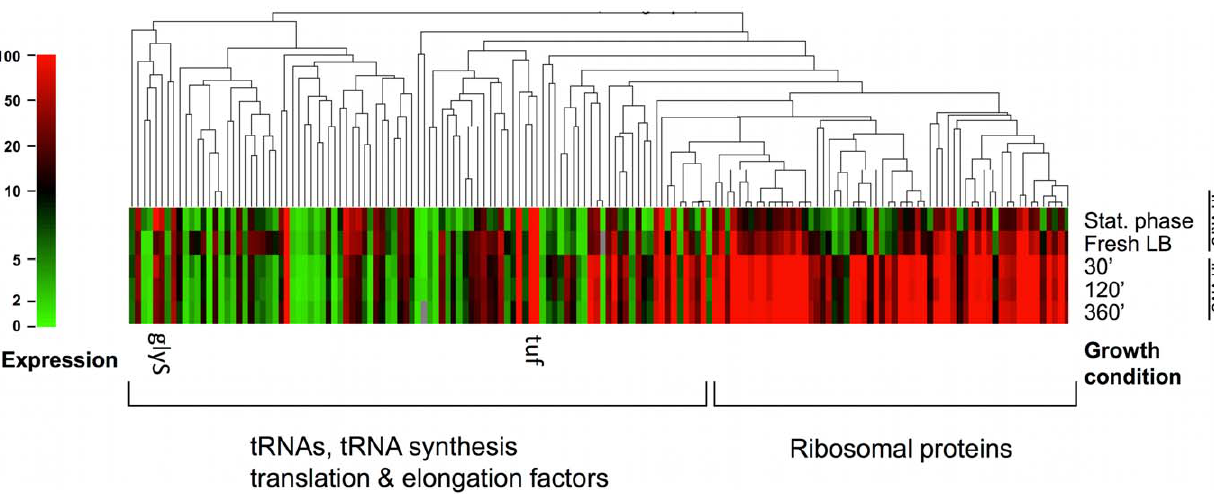
Figure 5. Gene tree with corresponding heat map of genes belonging to COG group J (translation). Genes were organized by average linkage clustering with distances determined by their pair-wise Pearson correlation coefficients. The scale on the left indicates transcriptional activity; classification into ribosomal protein synthesis compared to tRNAs, tRNA synthesis translation & elongation factors is depicted by brackets on the right. Columns in the heat map are labeled at the top with their corresponding growth conditions. Glycine tRNA glyS which had highest expression in stationary phase and translation factor tuf which was highly expressed under all conditions are labeled on the figure.